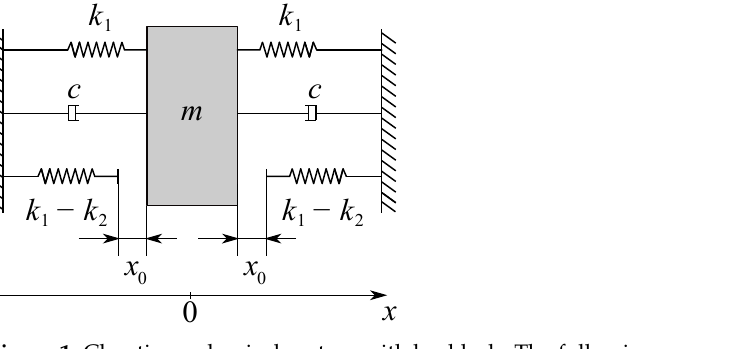
Figure 1. Chaotic mechanical system with backlash. The following parameters of the system were proposed by R. Lin and D. Ewins resulting in a chaotic behavior of the system under periodic excitation: c = 4 N · s/m, x 0 = 5 · 10 − 3 m, k 2 = 40,000 N/m, k 1 = 0